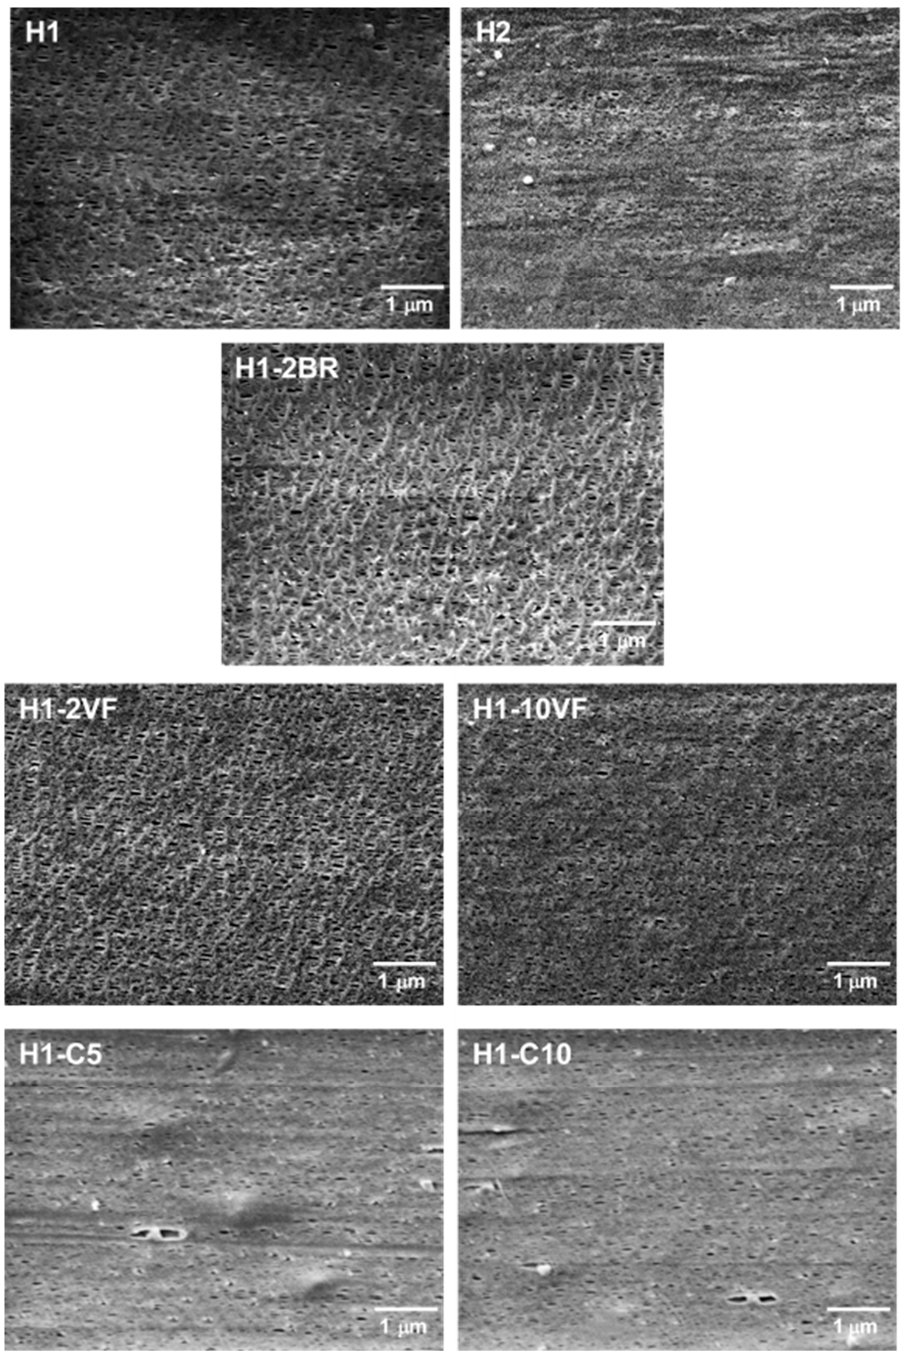
Figure 3. Scanning Electron Microscopy (SEM) micrographs differing in sample composition.